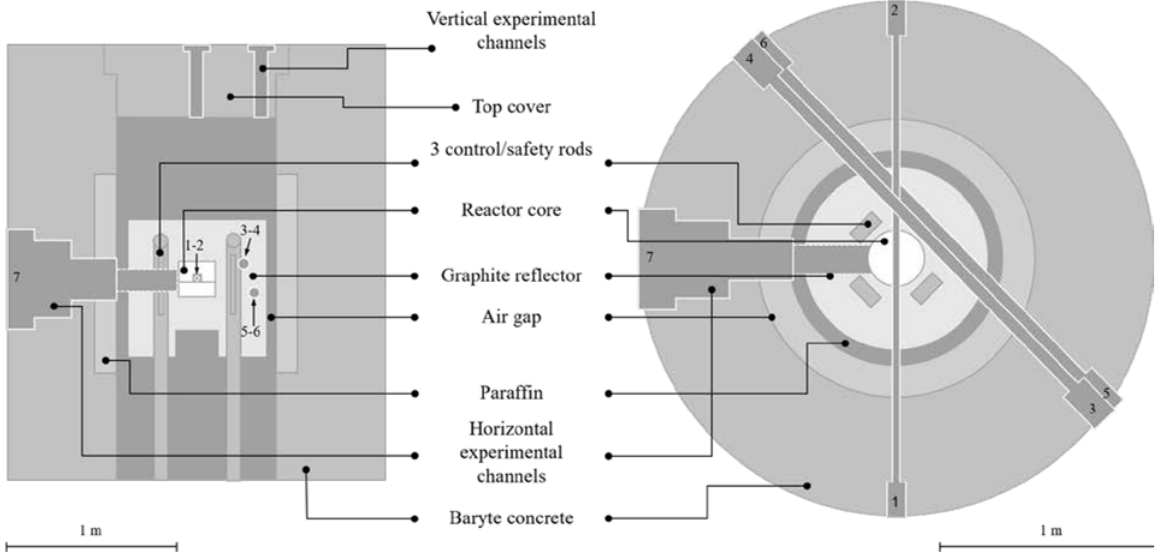
Figure 1. Vertical and horizontal cross section of the